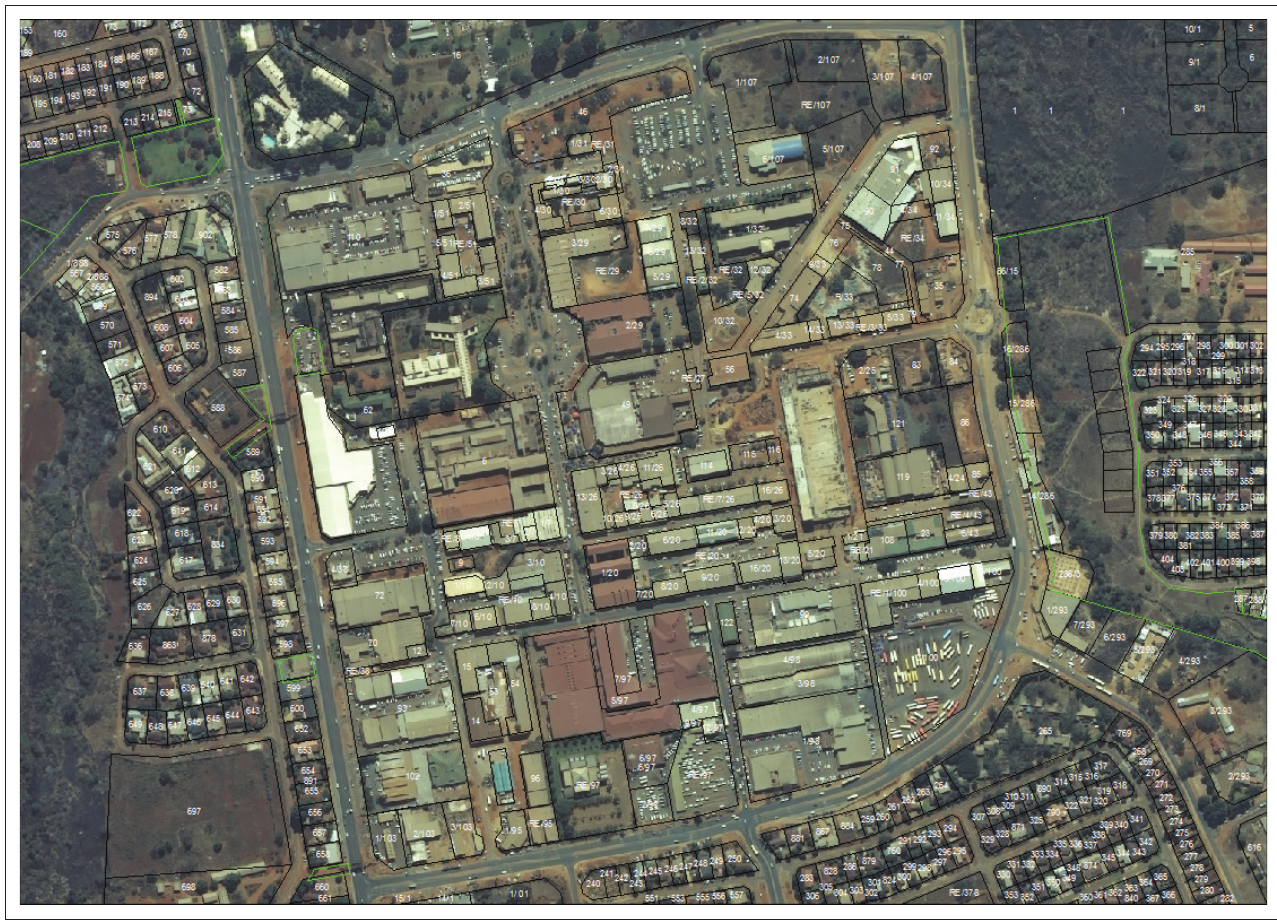
FIGURE 1: Thohoyandou central business district